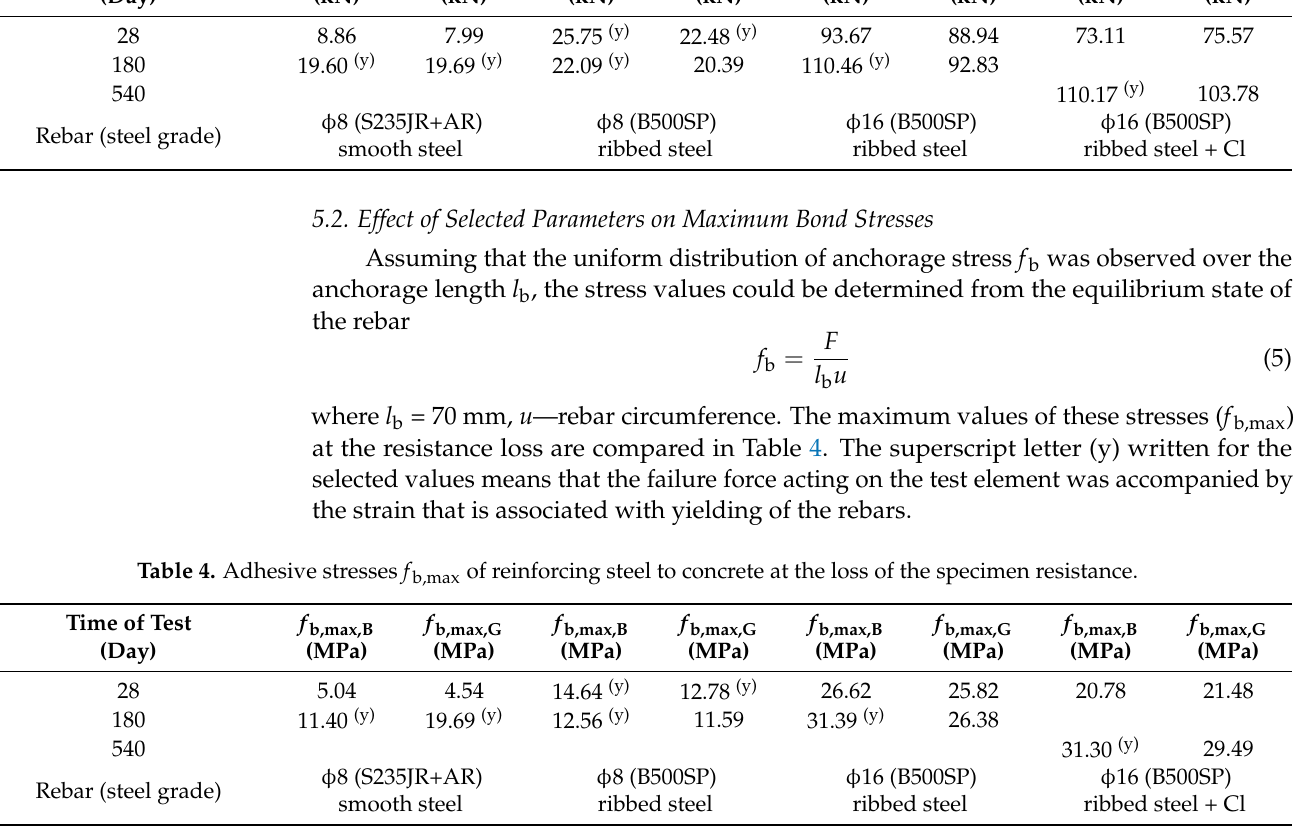
Table 3. The superscript letter (y) specifying the mean pull-out forces F max,B (the reinforcement without coating) and F max,G (the galvanized reinforcement) accompanied by yielding of the rebars. Time of Test